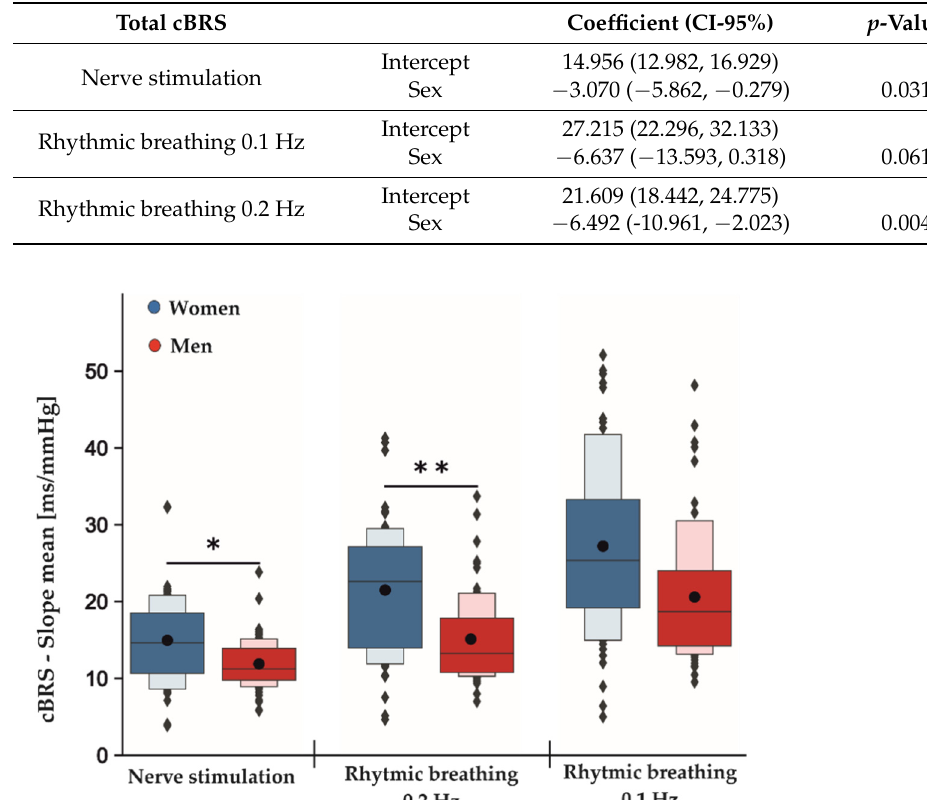
Table 3. Main sex effects of total cardiac baroreceptor sensitivity (cBRS). Results of linear mixed models are shown. Women are included in the Intercept, while males are represented in the variable “Sex”.